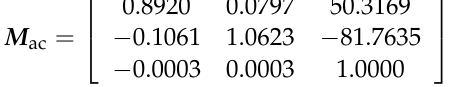
Figure 12. The rough matching results for the 0°and 35° images of the first scene: ( a ) the 0° image; ( b ) the 35° image.